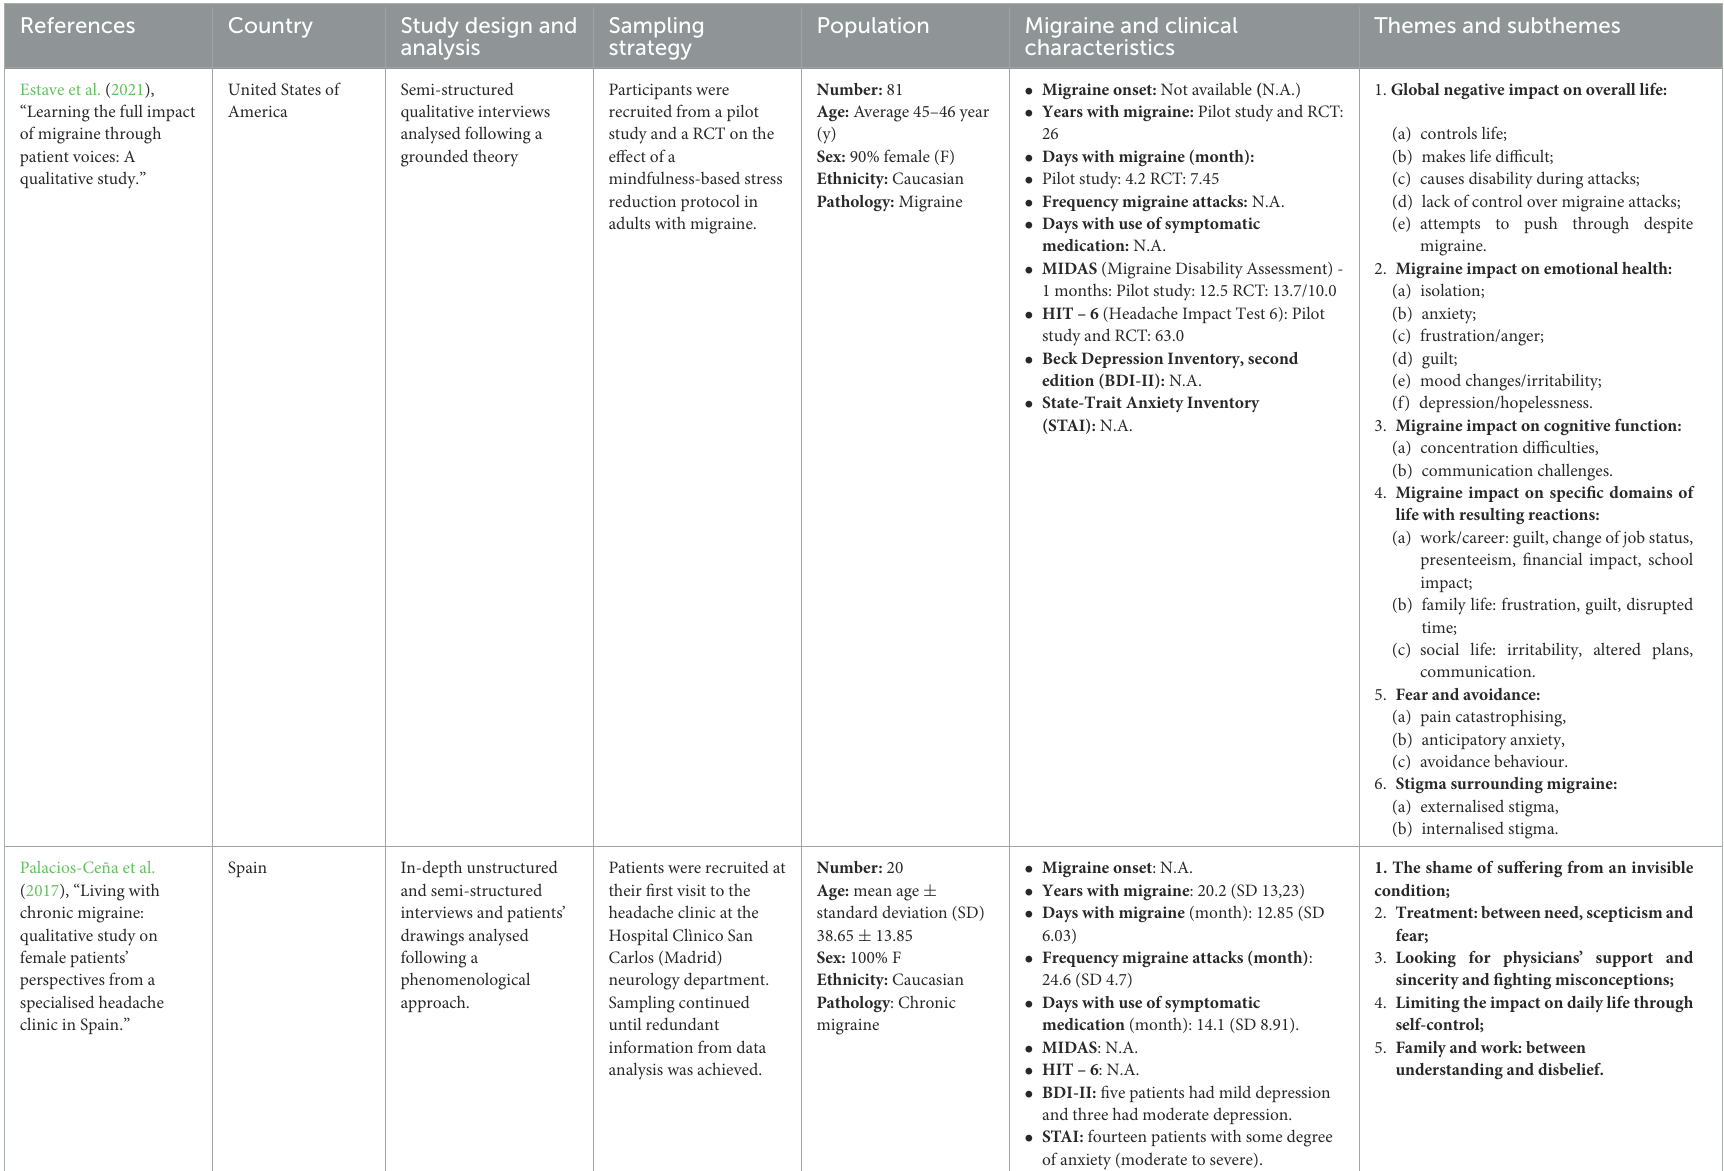
TABLE 1 Summary of